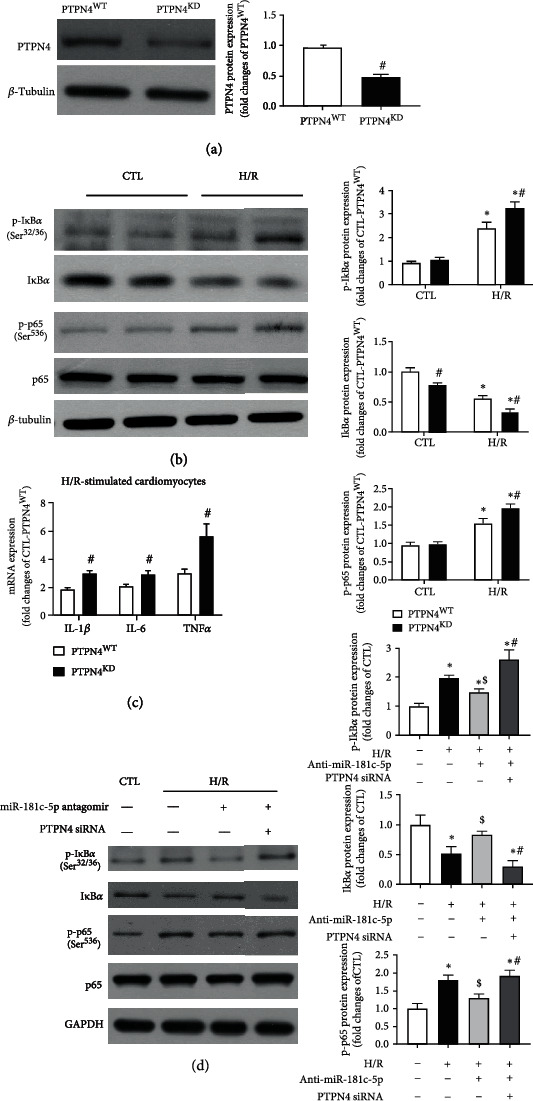
Reduction of PTPN4 mediated the proinflammatory effect of miR-181c-5p in H9C2 cardiomyocytes. (a) Transfection of cells with PTPN4 siRNA (PTPN4KD) resulted in significant reduction of PTPN4 protein level in H9C2 cardiomyocytes. (b) Representative Western blots of phosphorylated IκBα (Ser32/36), IκBα, phosphorylated p65 (Ser526), p65, and β-tubulin in the scramble siRNA or PTPN4 siRNA transfected H9C2 cardiomyocytes with or without H/R stimulation. (c) mRNA expression of NFκB-dependent genes, including IL-1β, IL-6, and TNFα in the scramble siRNA or PTPN4 siRNA-transfected H9C2 cardiomyocytes with H/R stimulation. mRNA levels are expressed as fold changes against those mRNA expressions in scramble siRNA-transfected H9C2 cardiomyocytes with no stimulation. (d) Representative Western blots of phosphorylated IκBα (Ser32/36), IκBα, phosphorylated p65 (Ser526), p65, and GAPDH in the H9C2 cardiomyocytes cotransfected with miR-181c-5p antagomir and PTPN4 siRNA and subjected to H/R stimulation. Protein presence of phosphorylated IκBα (Ser32/36), IκBα, and phosphorylated p65 (Ser526) was normalized to IκBα, β-tubulin/GAPDH, and p65, respectively. Data are shown as means ± SEM; ∗P < 0.05 vs. CTL or vs. NC agomir (NC) or no treatment group, #P < 0.05 vs. PTPN4WT or vs. H/R+miR-181c-5p antagomir, $P < 0.05 vs. H/R (two-tailed unpaired Student's t-test in (a, c), two-way ANOVA followed by Bonferroni test in (b), and one-way ANOVA followed by Bonferroni test in (d)), n = 5.